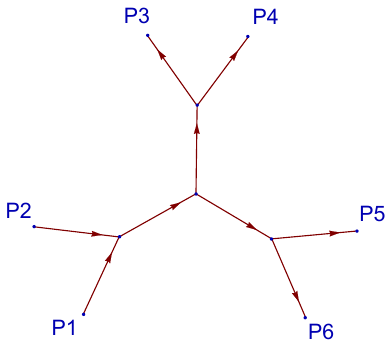
Figure 4 . Benzene-type